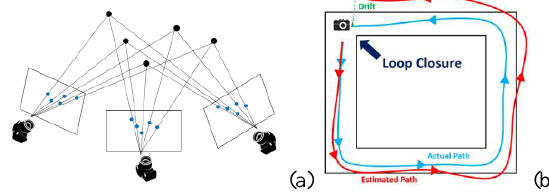
Figure 4. Local optimization (a) Bundle adjustment (b) Pose- graph optimization.